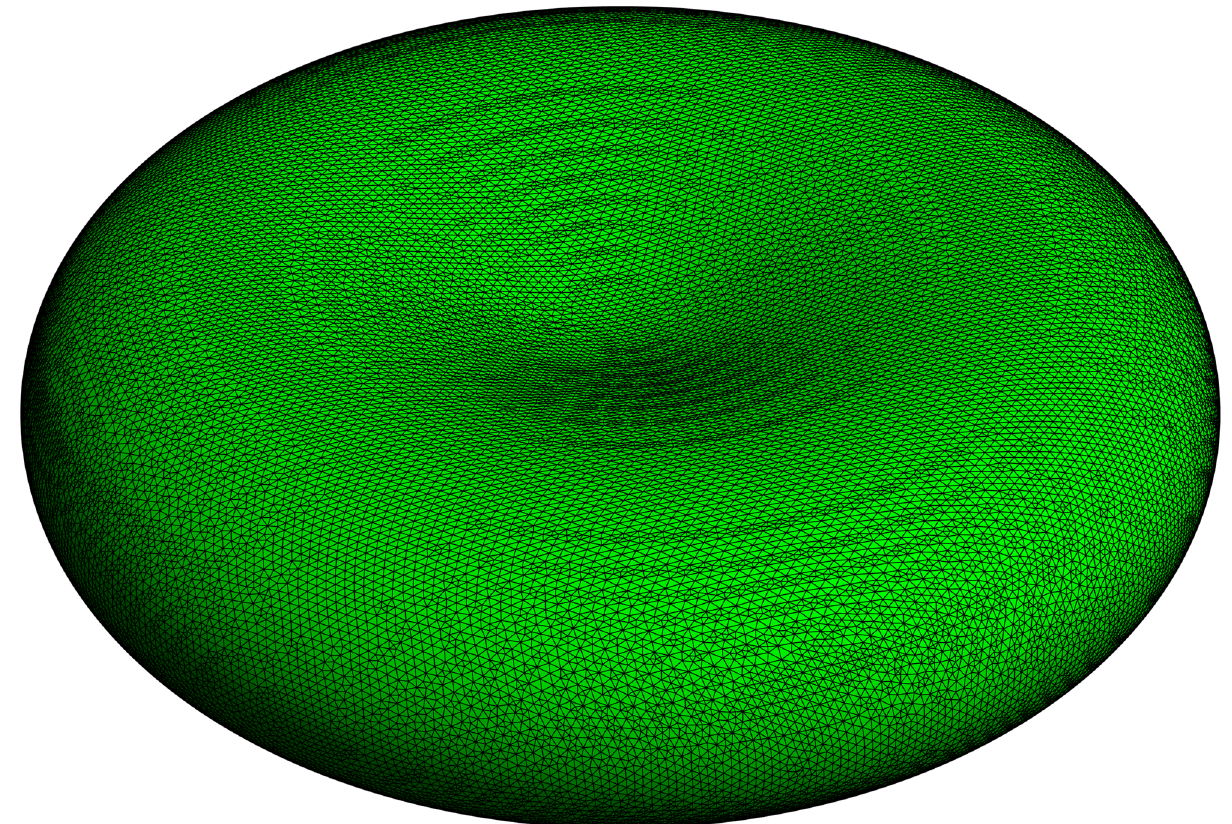
Figure 1. Triangular mesh of the RBC drawn to scale in its biconcave disc, using Eq. (1) in Mathematica . The main diameter d = 8 μm, thickness at the dimple b = 1 μm, and maximum height at the rim h = 2.12 μm. The triangularization was with BoundaryDiscretizationRegion, applied to ImplicitRegion (Supplementary Information). Number of edges = 120,042 and MeshCoordinates gave 40,136 points and 80,268 triangles. Green colouring was chosen over red (the natural choice for an RBC) for ease of visualizing the mesh. Notebook 2 has the Mathematica script used to generate this